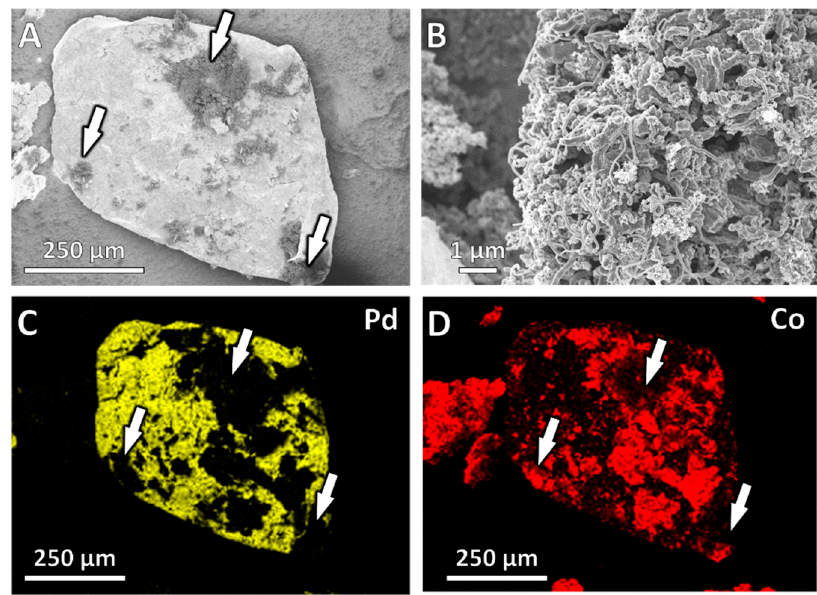
Figure 4. Pd-Co sample milled for 5 min and reacted at 550 °C for 5 min in 4:1 C 2 H 4 :H 2 . Secondary electron images of ( A ) the catalyst particle and ( B ) magnified image of the carbon deposited. EDS maps of ( C ) Pd and ( D ) Co corresponding to particle image in ( A ). White arrows indicate carbon deposits.